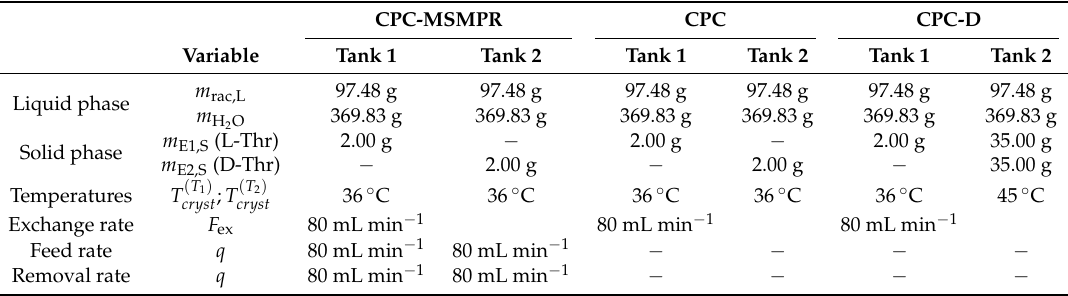
Table 1. Process conditions which are used for simulation studies. (CPC-MSMPR: Coupled preferential crystallization in mixed suspension mixed product removal; CPC: Coupled preferential crystallizer; CPC-D: Coupled preferential